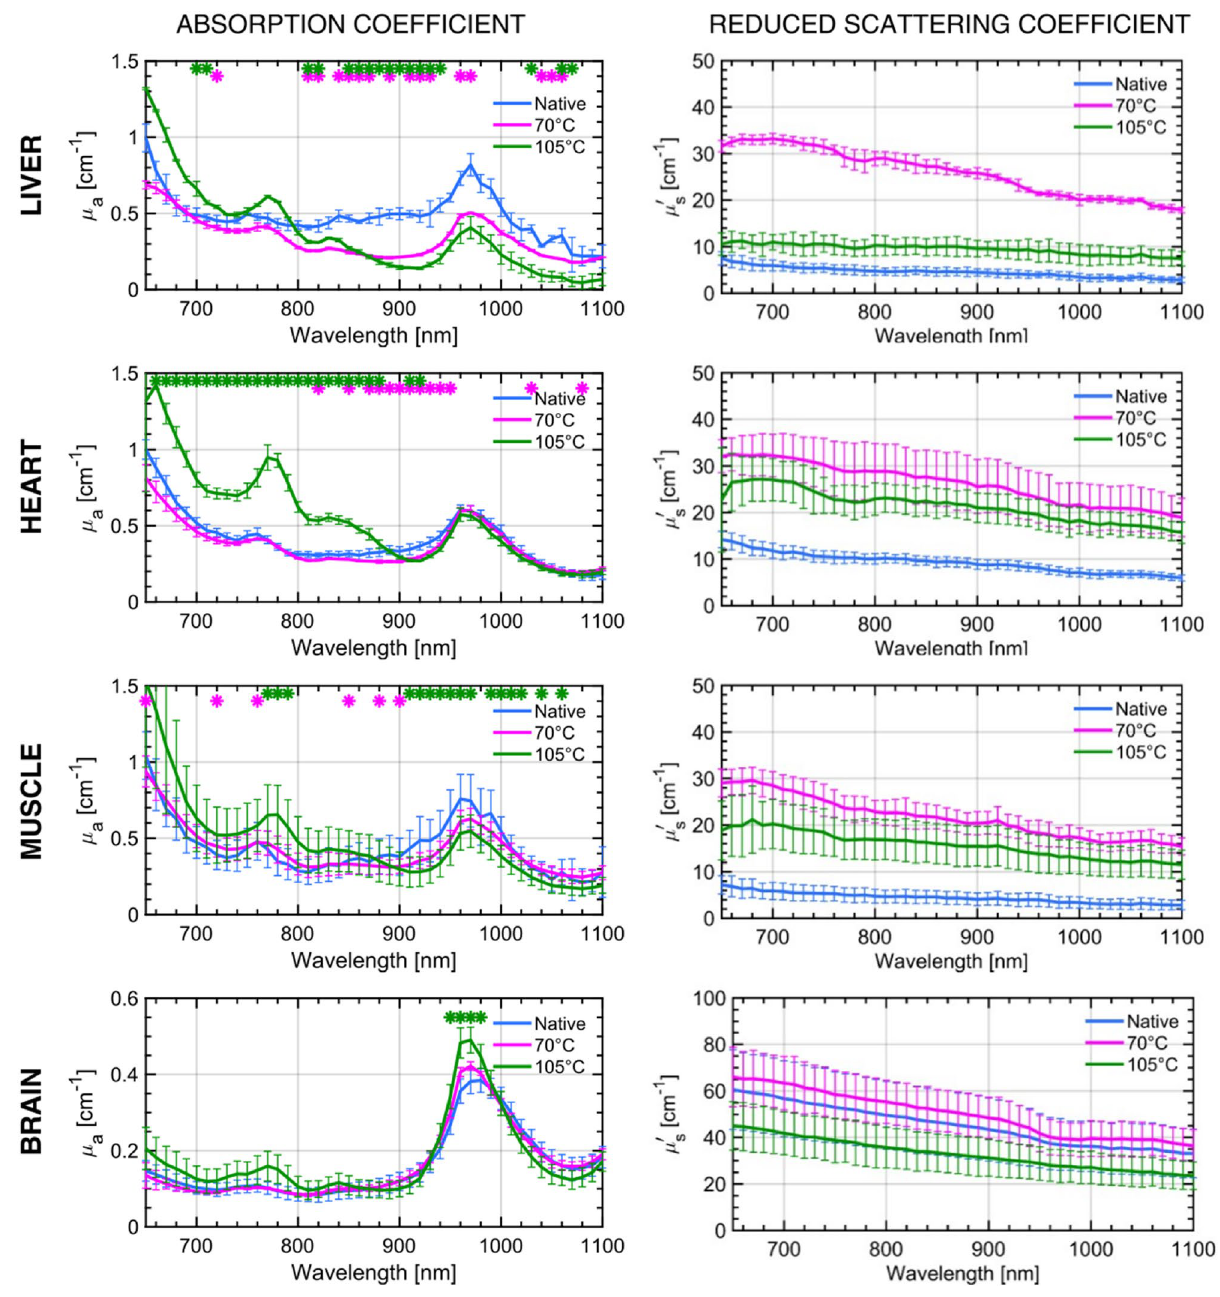
Figure 2. Optical properties of native and treated tissue. Broadband absorption ( µ a ) and reduced scattering ′ coefficient ( µ s ) spectra of native (blue) and tissues treated at two temperatures 70 °C and 105 °C (magenta and green respectively). The tissues are bovine ( a ) liver, ( b ) heart, ( c ) muscle and ( d ) brain. The spectra represent mean values of measurements performed on three different samples for each tissue type and the error bars show the standard deviation over the three measurements. The stars on top of each figure represent the statistically significant (p < 0.05) difference between the treated samples and the native ones at each